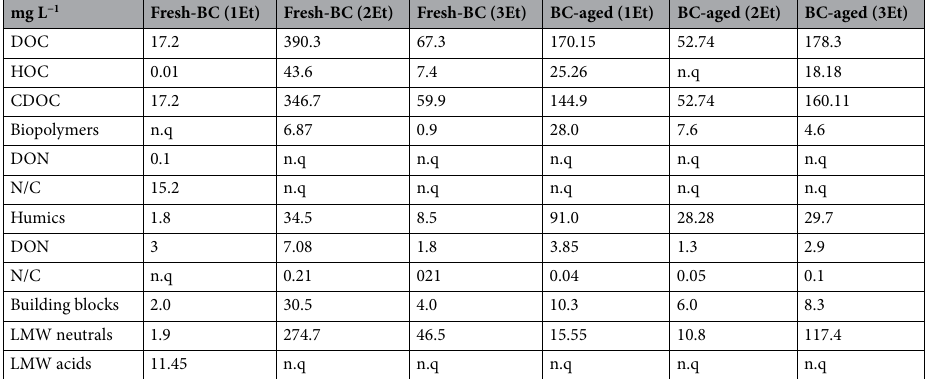
Table 3. The concentrations of different DOC fractions extracted from fresh and field-aged biochar in three repeated extractions (1Et–3Et). DOC dissolved organic carbon, HOC hydrophobic organic carbon, CDOC